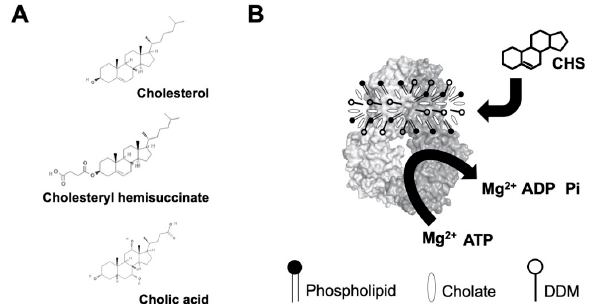
Figure 2. ( A ) Chemical structures of cholesterol, cholesteryl hemisuccinate (CHS), and cholic acid (cholate). Source: PubChem. ( B ) Schematic illustration of sterol-coupled ATPase activity of ABCG5 / G8. Dodecyl-maltoside (DDM)-purified ABCG5 / G8 (light / dark-gray surface) is preincubated with phospholipids and cholate. Addition of CHS (four-ringed steroid structure) stimulates hydrolysis of ATP to ADP and inorganic phosphate (Pi) in the presence of the divalent magnesium ions (Mg 2 + ). Using the colorimetric and bismuth citrate-based assay, the liberated Pi is then captured by ammonium molybdate in the presence ascorbic acid. The color is developed upon mixing with bismuth citrate and sodium citrate, and the absorbance was measured at 695 nm. See details in Section